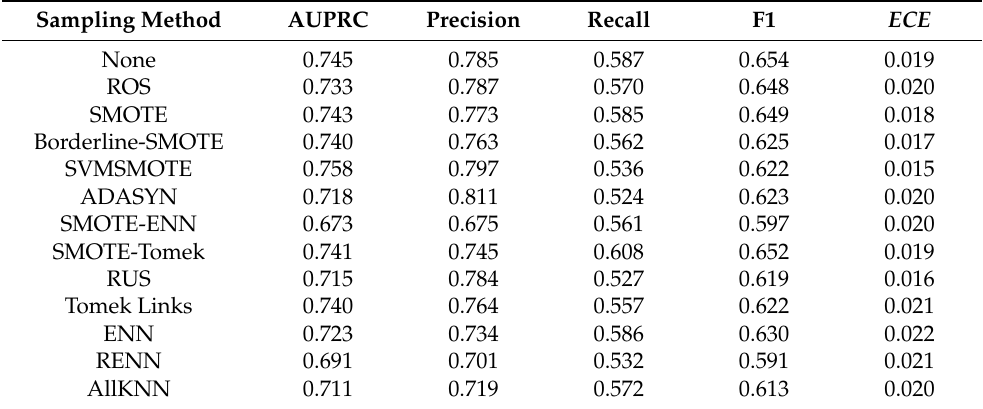
Table 3. Results of different sampling methods with weighted cross-entropy loss function and isotonic regression.